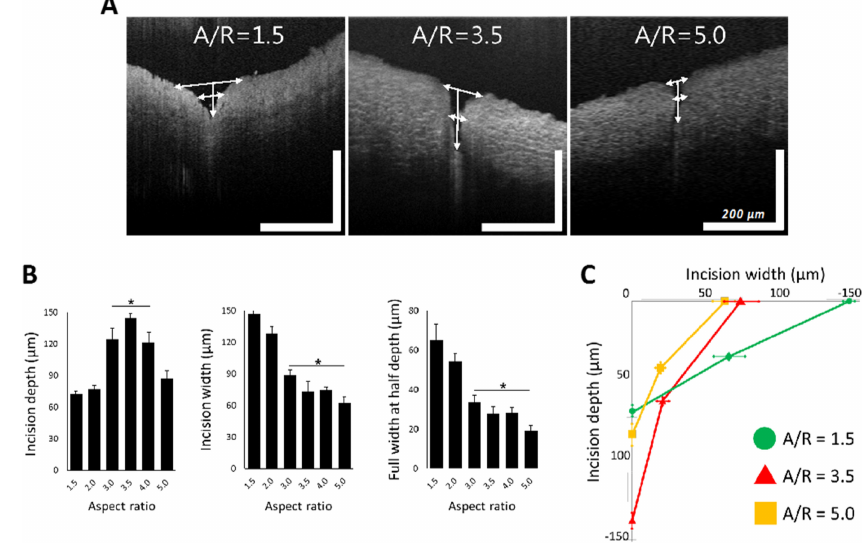
Figure 7. ( A ) Representative optical coherence tomography images of ex vivo inserted tissues with aspect ratio (A/R) 1.5, 3.5, and 5.0 microneedles (MNs). ( B ) Incision depth, incision width, and full width at half depth of rabbit abdominal aorta with different A/R MNs. In the plot of incision depth, * p < 0.01, compared with A/R 1.5 and 2.0 group ( p = 0.002 by ANOVA). In the plots of incision with full width at half depth, * p < 0.05, compared with A/R 1.5 and 2.0 group ( p = 0.007 by ANOVA). All data were presented as the mean ± standard error of the mean. ( C ) Integrated plot from data in Figure 7A, in the case of A/R 1.5, 3.5, and 5.0 MN insertion (scale bar = 200 µ m (width and length